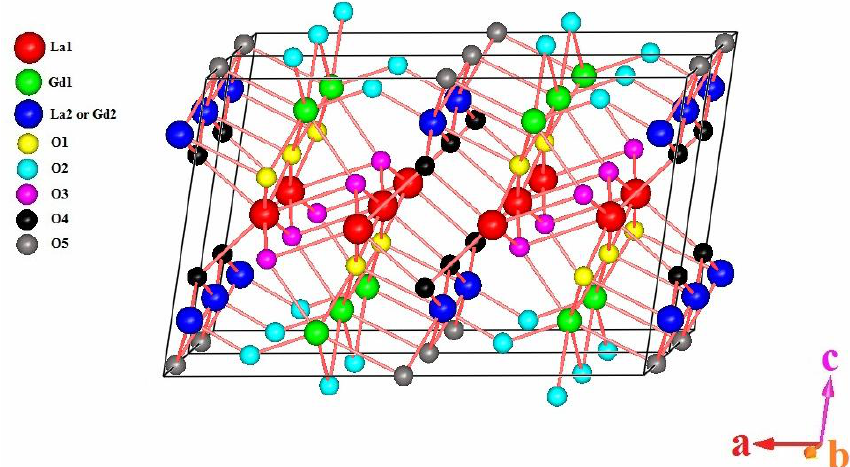
Figure 2. A three-dimensional sketch of the refined B-type monoclinic structure. Reprinted with permission from [11]. Copyright 2014 WILEY-VCH Verlag GmbH & Co.